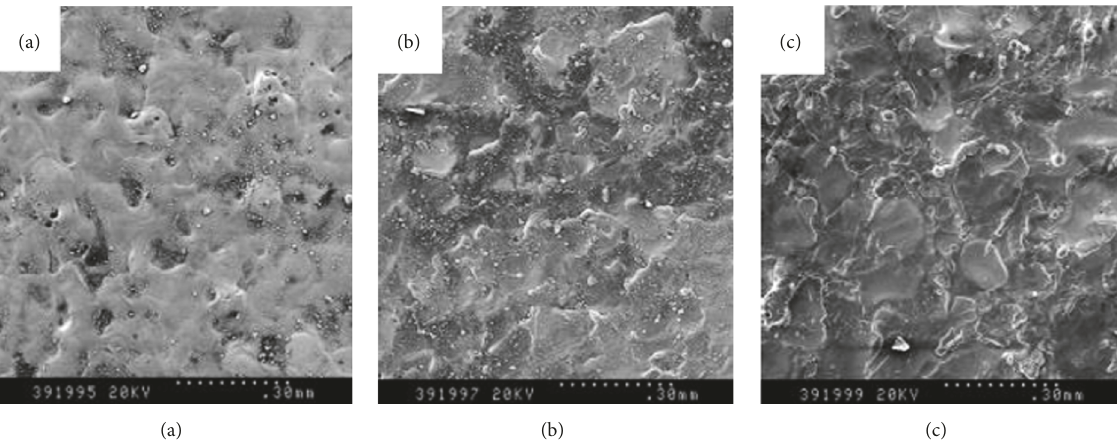
Figure 16: Surface topography of the machined samples in (a) argon, (b) nitrogen, and (c) oxygen. Copyright @Elsevier, reproduced with permission from Elsevier